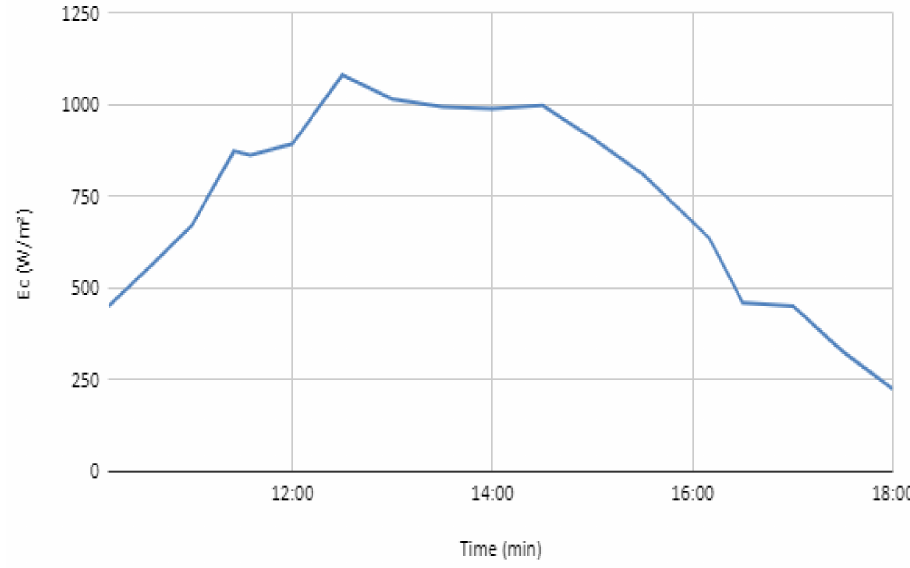
Figure 13. Rate of daily irradiation variation in (W/m 2 ).